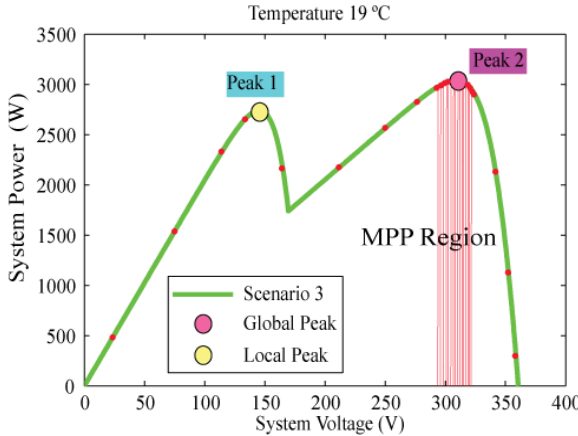
Figure 18. PV characteristics curve for scenario three.